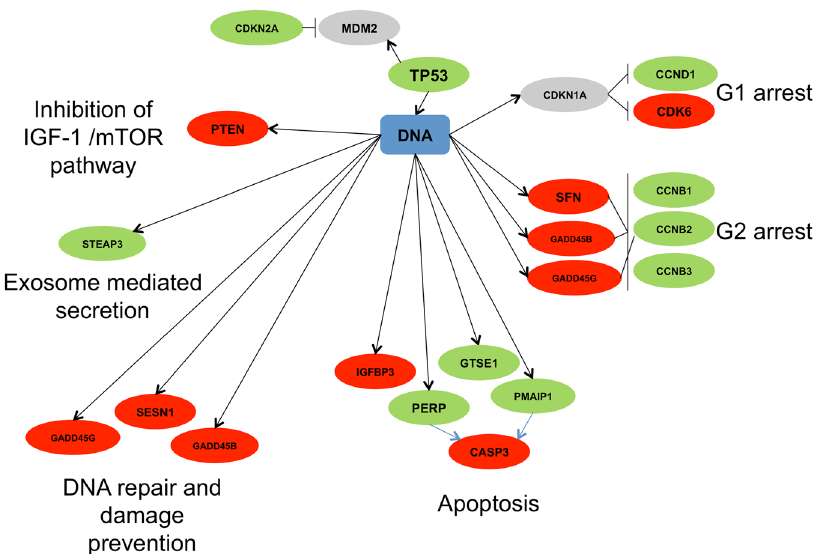
Figure 4. Map of DEGs in Oncopig STS cell lines and their functions within the TP53 signaling pathway. Adopted from the KEGG hsa04115 p53 signaling pathway. Green ovals represent genes with elevated expression, red ovals represent genes with reduced expression, and grey ovals represent genes with no expression change in Oncopig STS cell lines compared to controls. Black bars represent inhibition, black arrows represent activation, and blue arrows represent indirect